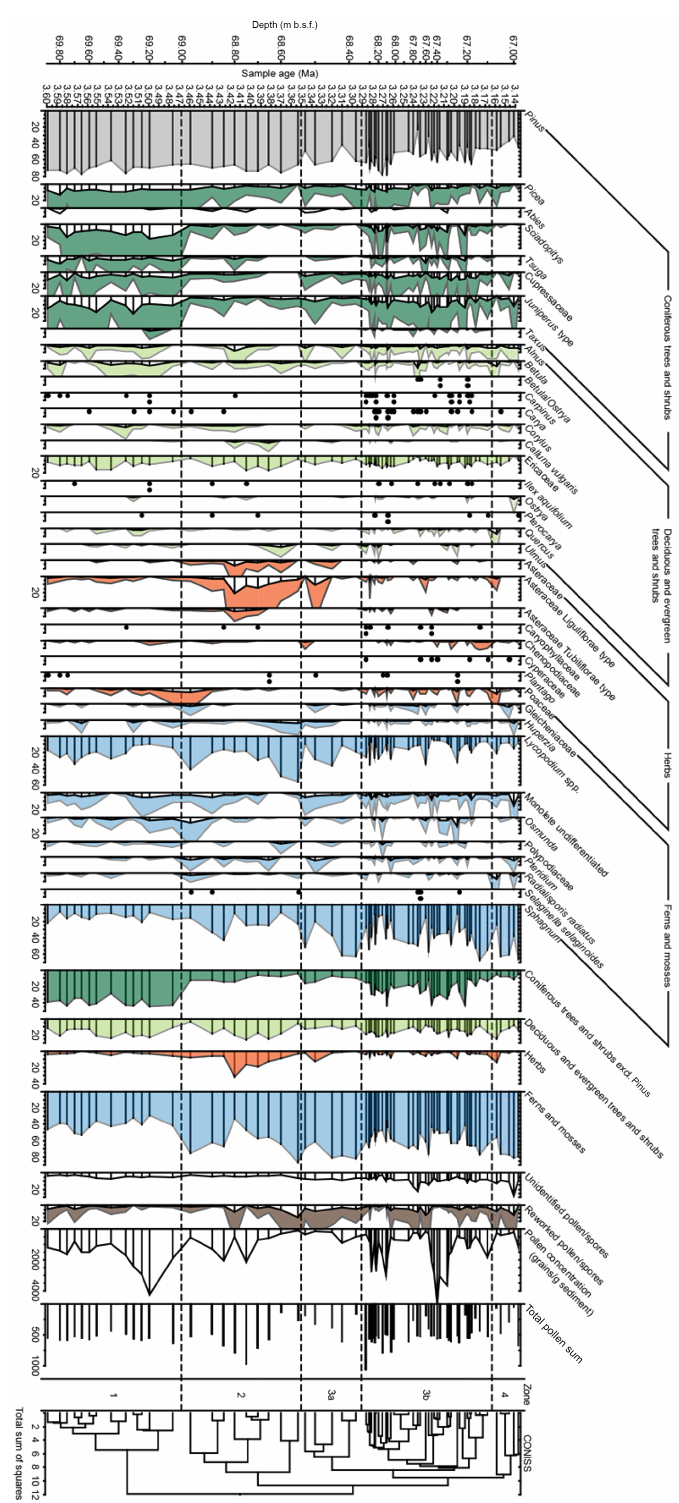
Figure 5. Pollen assemblages in the Piacenzian sediments of ODP Hole 642B. Non-patterned, coloured area represents 5-fold percentages. Black circles are representative of single pollen or spore grains. Percentages of pollen and spores were calculated based on the pollen sum, excluding Pinus , unidentified and reworked pollen and spores. Pinus was included in the pollen sum to calculate percentages of Pinus . The total pollen sum shown here comprises Pinus and unidentified pollen. Depth is indicated in metres below sea floor